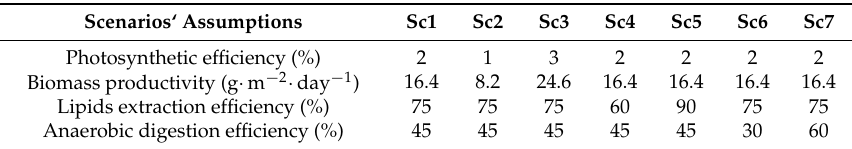
Table 1. Characterization of the seven scenarios (Sc) evaluated in this